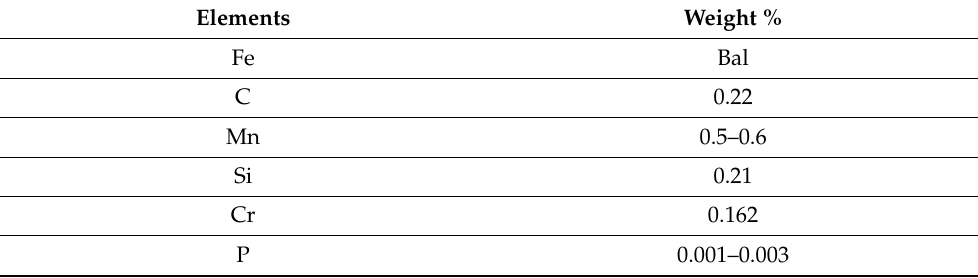
Table 3. Elemental composition of AISI 1018 steel in weight %.